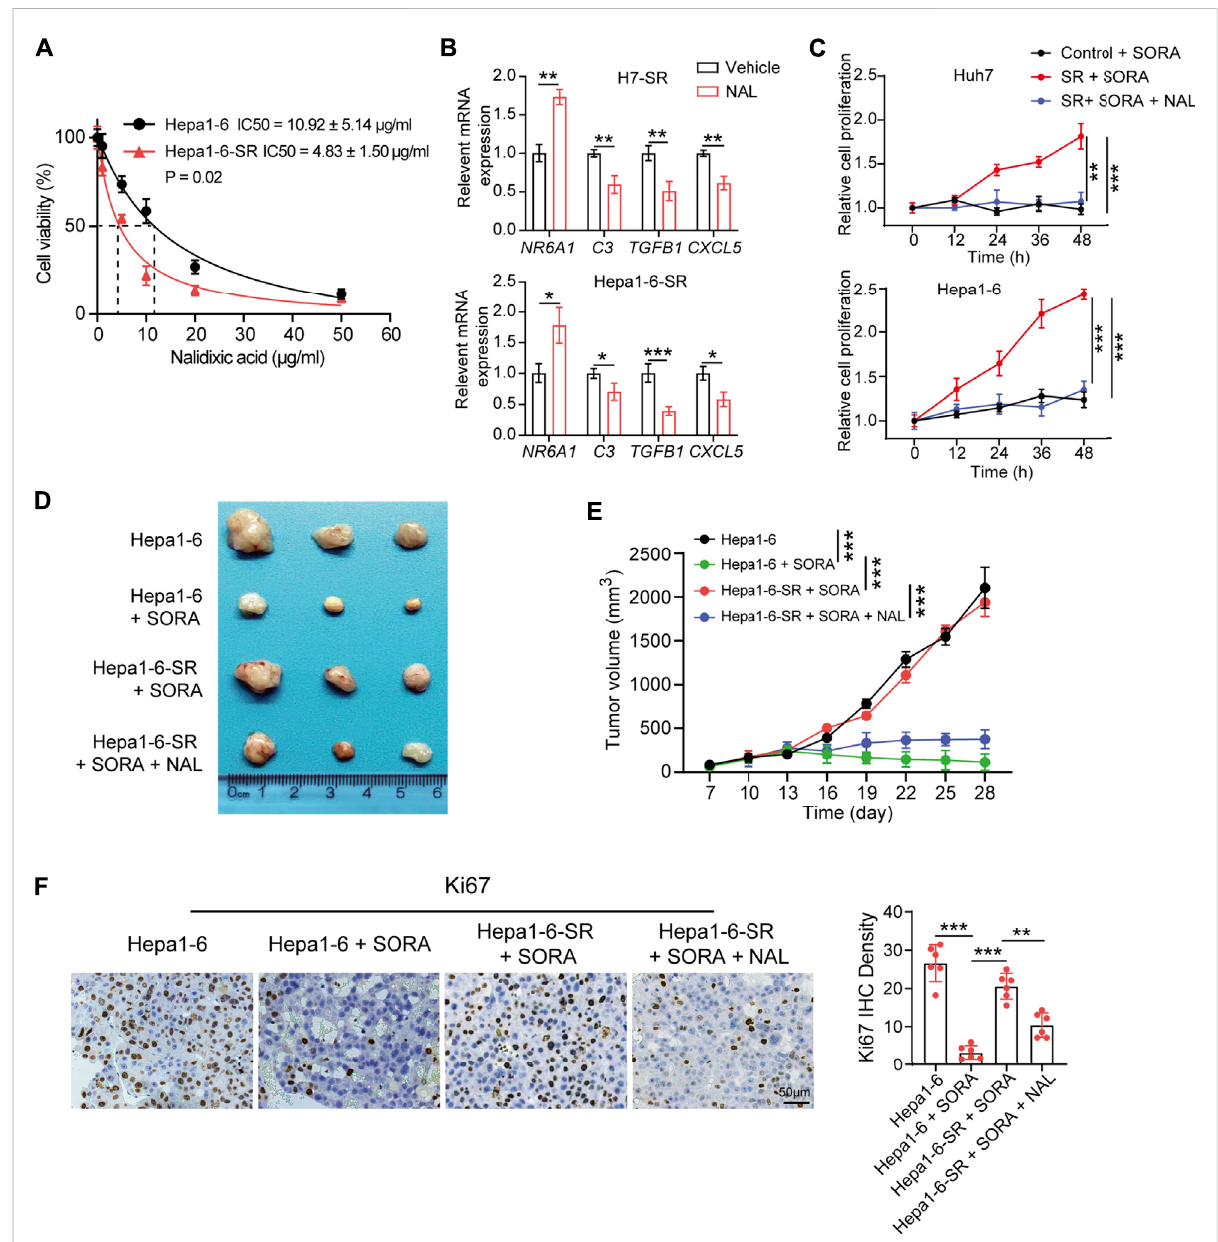
FIGURE 7 Nalidixic acid overcomes sorafenib resistance and inhibits HCC development. (A) Cell viability showing the IC 50 concentrations of nalidixic acid treatment in Hepa1-6-SR and parental Hepa1-6 cells. (B) Expression changes of four prognostic DEIRGs ( NR6A1, CXCL5, C3, and TGFB1) in sorafenib-resistant HCC cells treated with nalidixic acid. (C) CCK-8 assay assessed cell viability in Huh7-SR and Hepa1-6-SR cells treated with sorafeniborsorafenibplusnalidixicacid. (D) Representativephotosoftumorspresentedafter4weeksofdifferenttreatments. (E) Tumorgrowth curves of different treatments in the sorafenib-resistant HCC mouse model. (F) IHC staining of Ki67 in different treatment